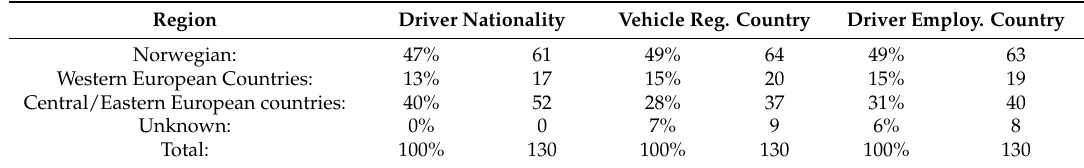
Table 1. Nationality of drivers, vehicle registration country and driver employment country. Region Driver Nationality Vehicle Reg. Country Driver Employ.